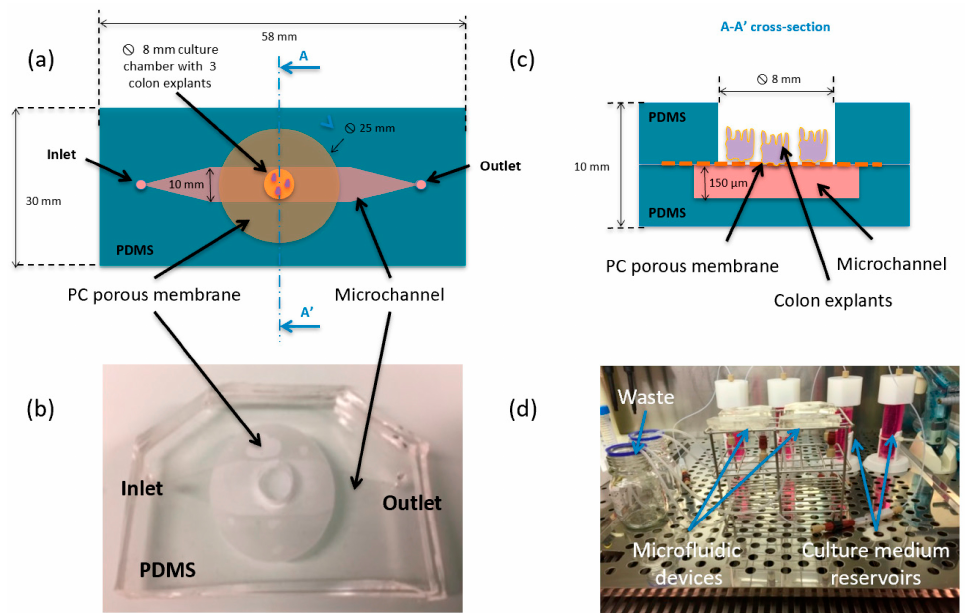
Figure 4. Gut-on-a-chip microfluidic device. ( a ) Schematic top view of the system made of two polydimethylsiloxane (PDMS) layers and one polycarbonate (PC) membrane; ( b ) current assembled device; ( c ) schematic drawing of the A-A’ cross-section; and ( d ) entire setup (including 4 devices, 9 colon explants, and 4 independent culture medium reservoirs and wastes) placed in an incubator. Reprinted from an open-access source [101].